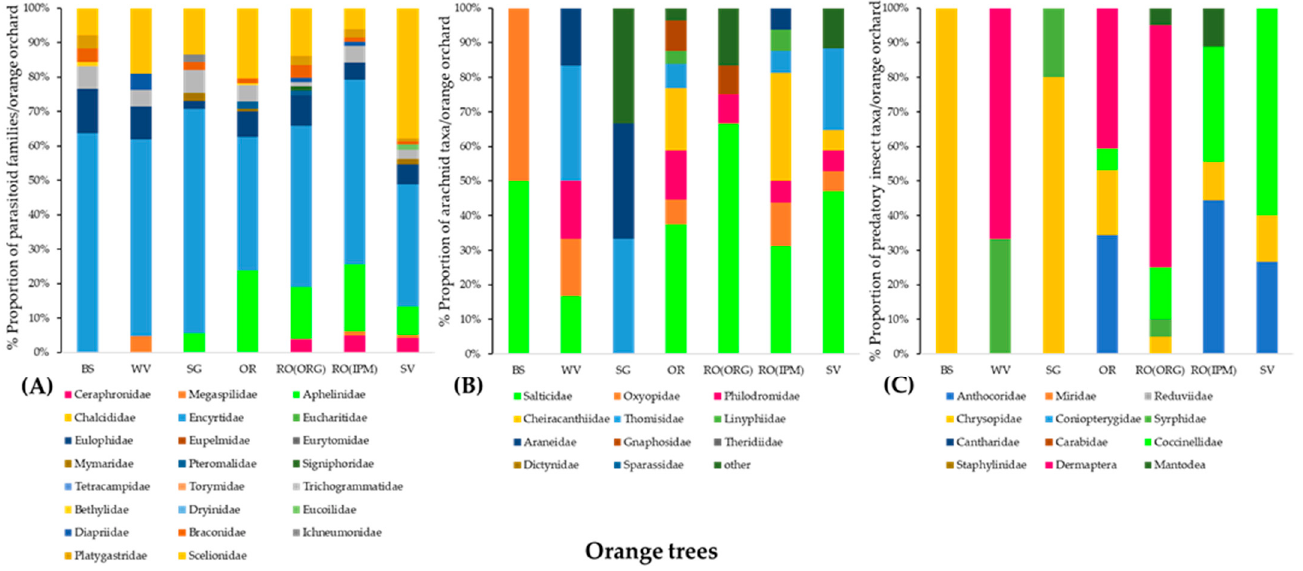
Figure 4. Community composition of ( A ) Hymenoptera parasitoids, ( B ) arachnid predators, and ( C ) insect predators on orange trees in seven orchards (BS, WV, SG, OR, SV, RO(ORG), and RO(IPM)) at the baseline year (field margin management using the usual farmers’ practice).